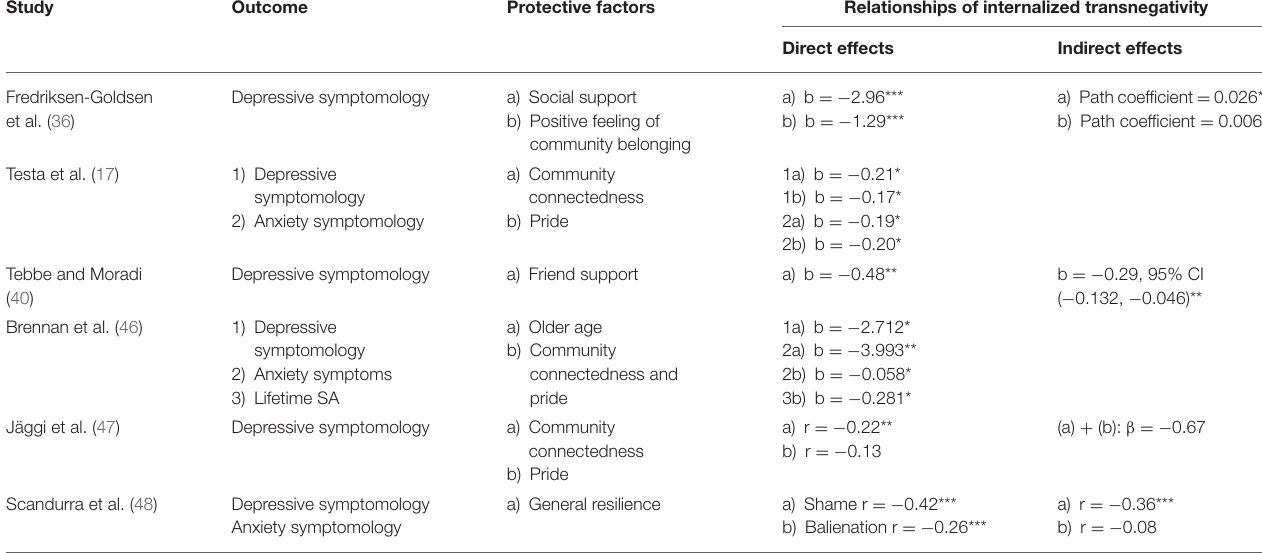
TABLE 9 | Results overview, protective factors. Study Protective factors Relationships of internalized